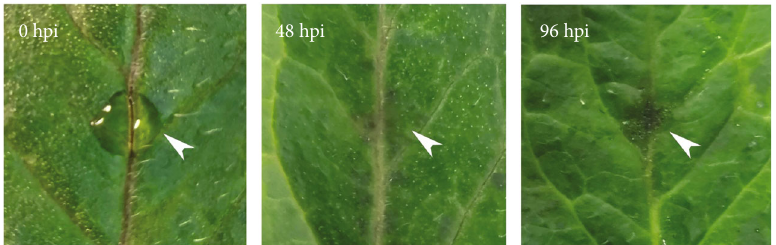
Figure 1: Symptom development on tomato leaves inoculated with a spore suspension of S . lycopersici . The spore suspension was inoculated on tomato leaves (0 hpi), brown spots began to appear at 48 hpi, and signi fi cant local leaf cellular necrosis was observed by 96 hpi. Table 1: Summary of the RNA-seq data.